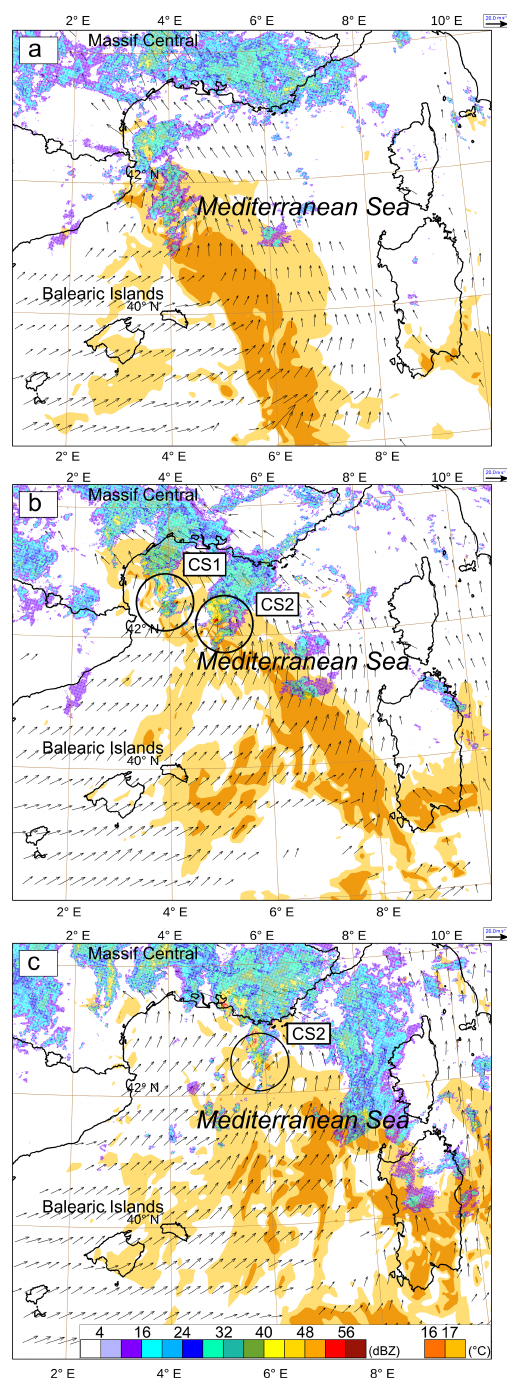
Figure 2. Observed radar reflectivity (colour scale, dBZ) superim- posed onto AROME analysis for IOP16a in terms of adiabatic wet- bulb potential temperature (coloured areas) and horizontal winds greater than 20ms − 1 (arrows) at 925hPa valid at (a) 06:00UTC, (b) 09:00UTC, and (c) 12:00UTC on 26 October